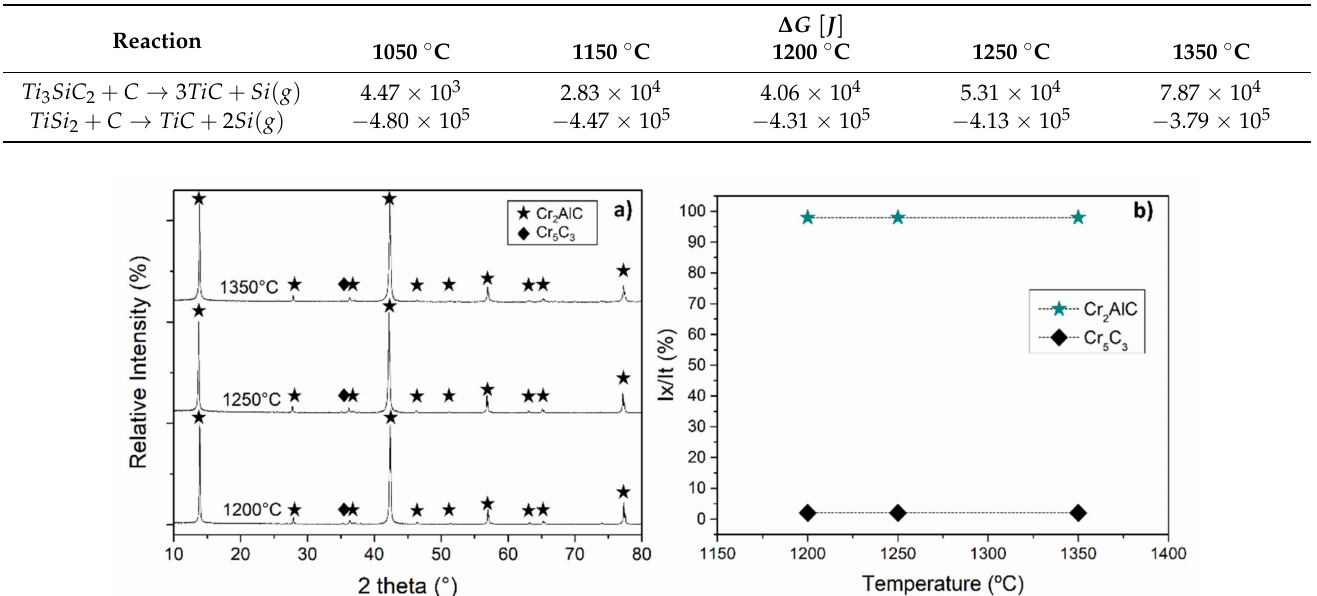
Figure 5. ( a ) The X-ray diffraction patterns of hot-pressed Cr 2 AlC powders from 1200 ◦ C to 1350 ◦ C and ( b ) the phase evolution from the XRD